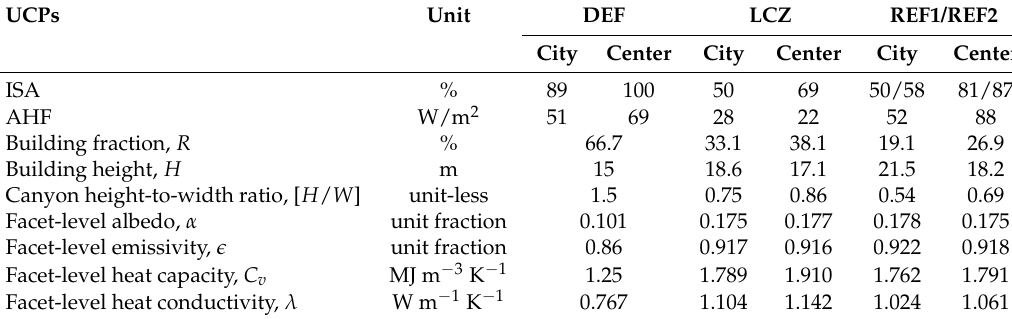
Table 2. UCP values for DEF, LCZ and REF, averaged within the major part of the city (within Moscow administrative borders for the year of 2011, that approximately corresponds to Moscow Ring Road) and within the central part of the city (within a distance of 5 km from Kremlin, that approximately corresponds to Third Ring Road). For the morphological and thermal UCPs in LCZ and REF, the values are weighted by ISA when averaging. UCPs Unit LCZ